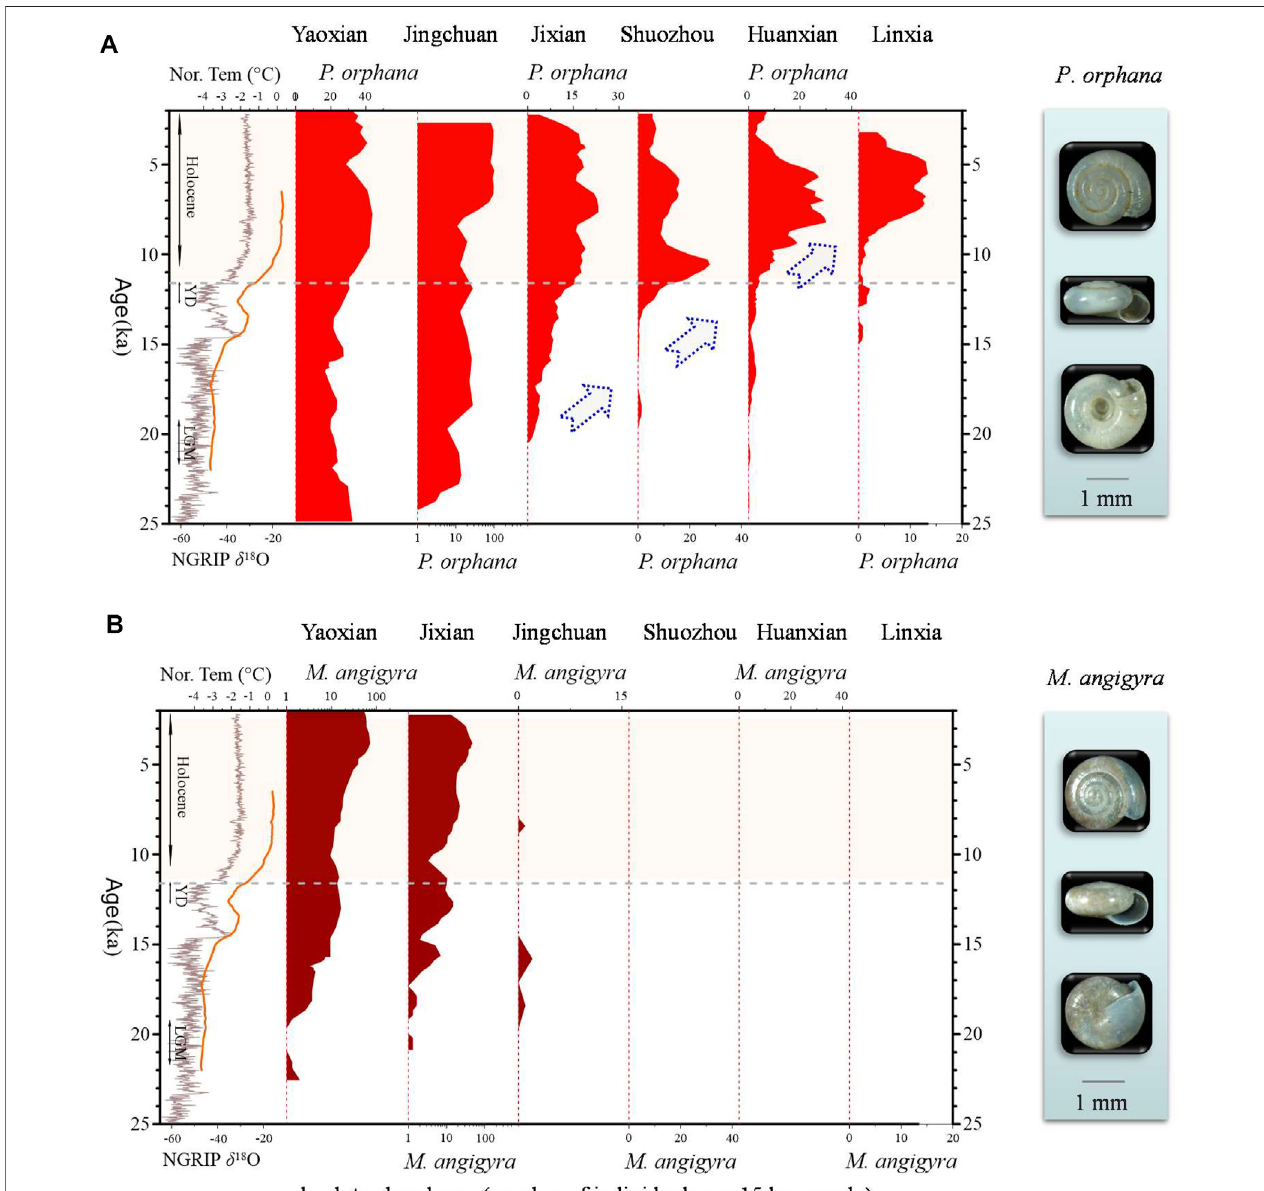
FIGURE 3 | Abundance of P. orphana (A) and M. angigyra (B) in the six loess sections from southeast to northwest across the Chinese Loess Plateau, and correlationwiththeGreenlandNGRIPice-core δ 18 Orecord(Huberetal.,2006)andNorthernHemisphereaveragetemperature(Nor.Tem)( ° C)(Shakunetal.,2012).The Holocene, Younger Dryas (YD) and LGM intervals are indicated. The shaded zones indicate the Holocene soil layer.